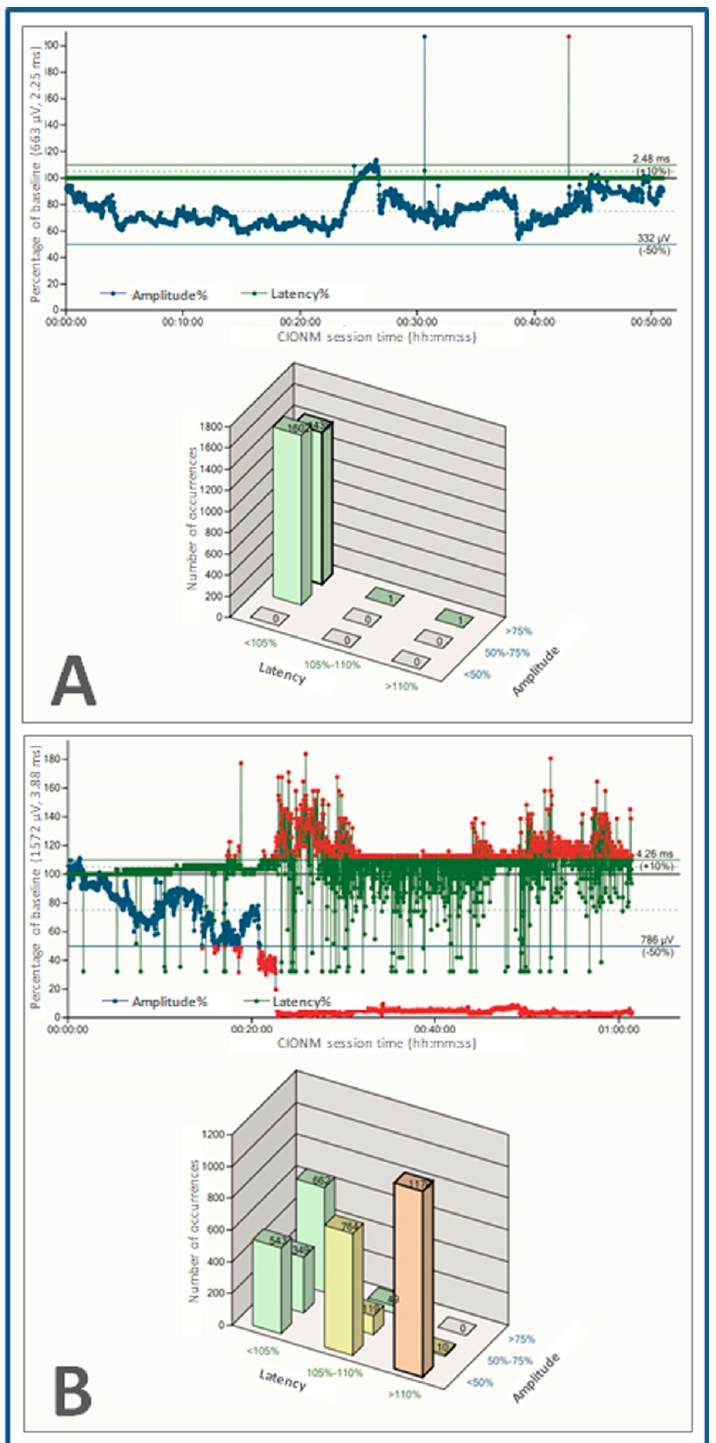
Figure 3. Electromyogram tracings with preset amplitude (blue line) and latency (dark green line) thresholds with automatic periodic stimulation at 1 Hz. ( A ) Normal electromyogram (amplitude of 663 µV and latency of 2.25 ms at baseline) heralding normal postoperative vocal cord function. ( B ) Definitive loss of signal (combined event) without intraoperative recovery, signaling an ipsilateral vocal cord palsy.